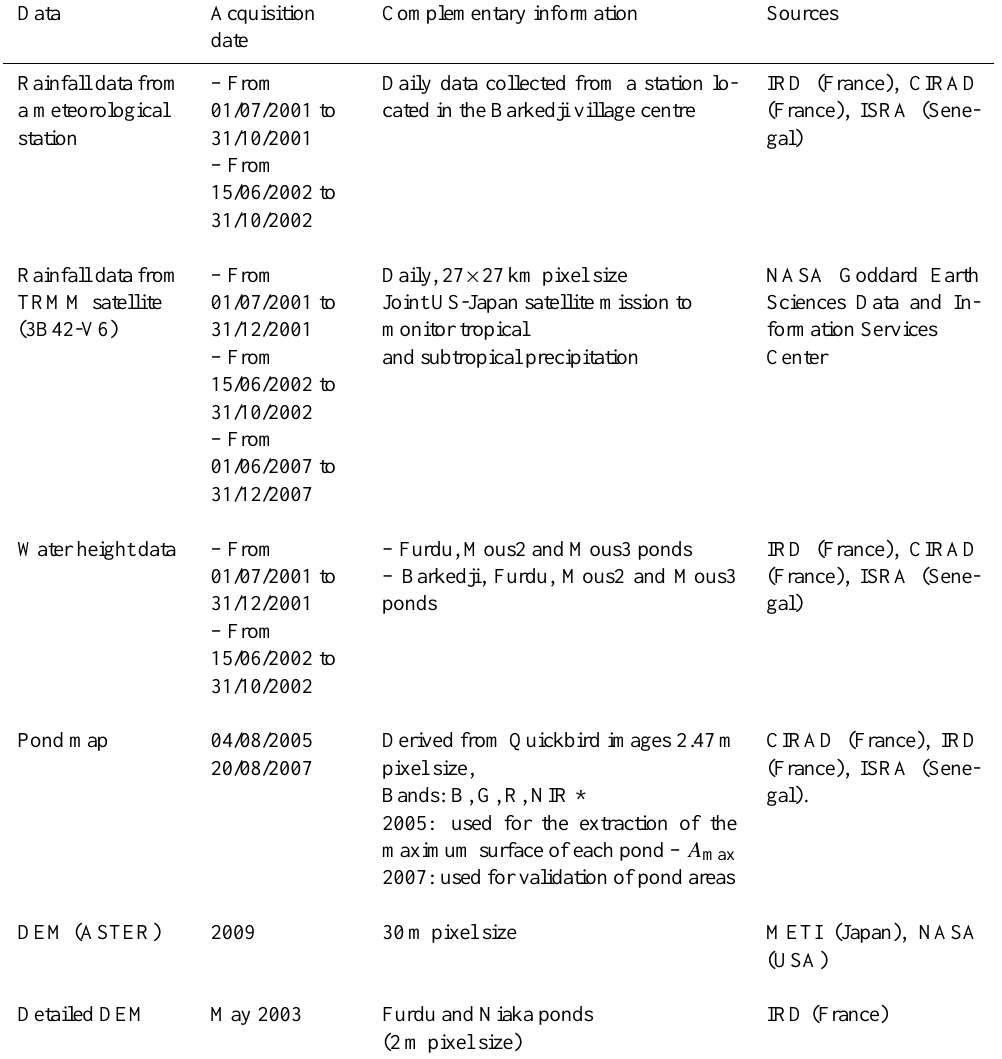
Table 1. Summarized characteristics of the data